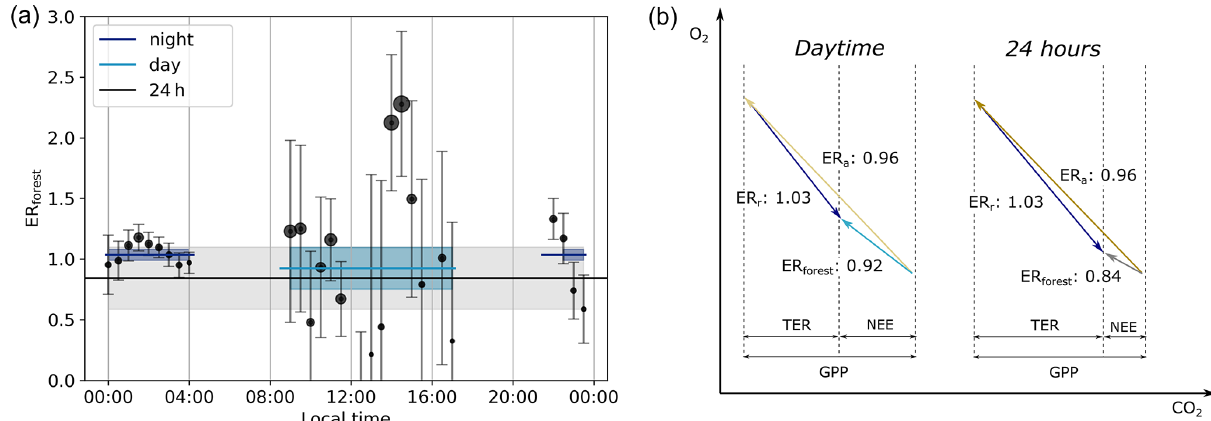
Figure 7. The half-hourly exchange ratio of the forest (ER forest ) and the resulting averaged ER forest for the entire day (black line), the night between 21:00–04:00 (dark blue line), and the day between 09:00–17:00 (light blue line) of the representative day (a) with the time in local wintertime (LT; time zone UTC+2). The size of the dots indicates the size of the absolute O 2 flux, and the shaded bands indicate the uncertainties of the different ER forest signals. Note that the ER forest lines do not match with the average of the dots in the specific time period, because the lines are based on the averaged fluxes. These different ER signals are presented in a vector diagram format with the carbon fluxes, gross primary production (GPP), total ecosystem respiration (TER), net ecosystem exchange (NEE), the ER of the assimilation processes (ER a ), and the ER of the respiration processes (ER r ) (b) .